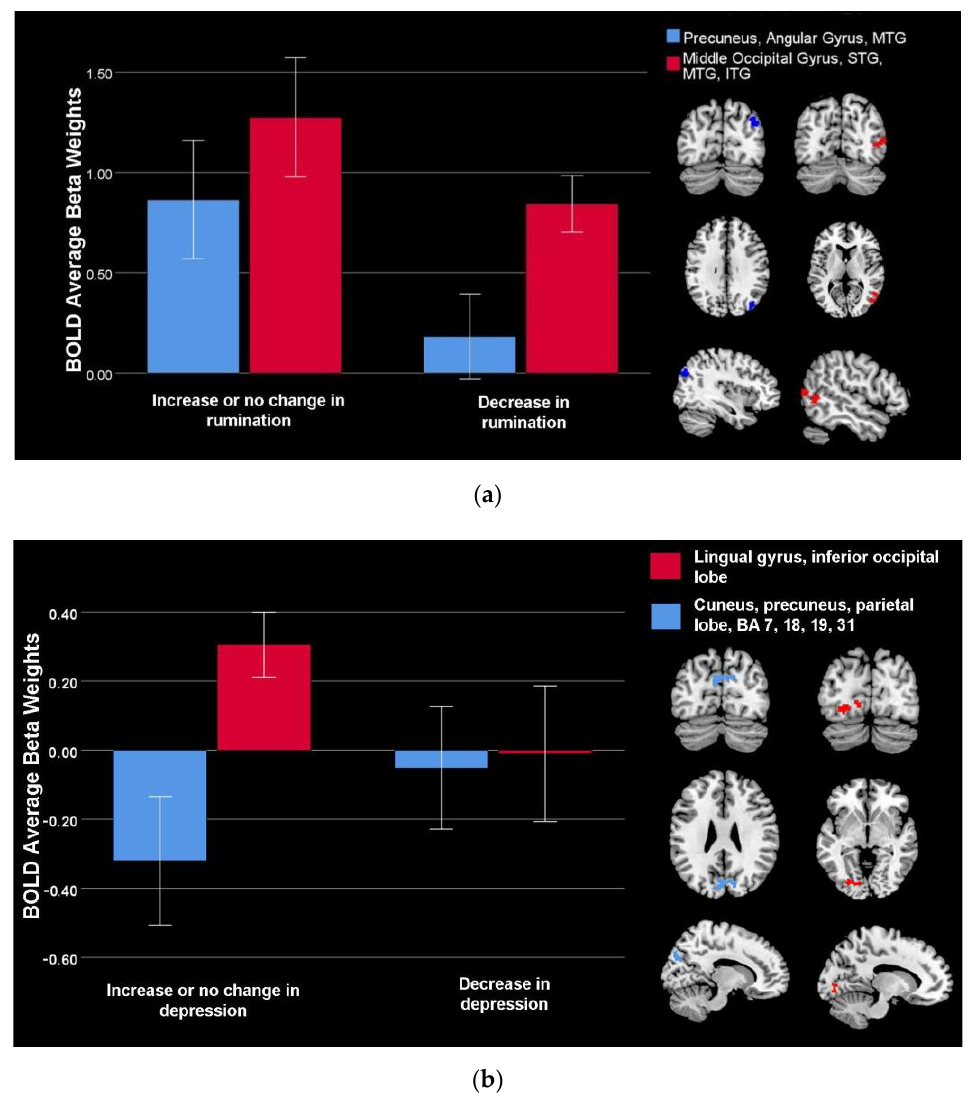
Figure 2. Brain activity associated with symptom change during neurofeedback (feedback vs. count—backwards) in depressed youth, n = 34: ( a ) Changes in brain activity during neurofeed- back vs. counting backward associated with decreased rumination; ( b ) Changes in brain activity during neurofeedback vs. count—backwards associated with decreased